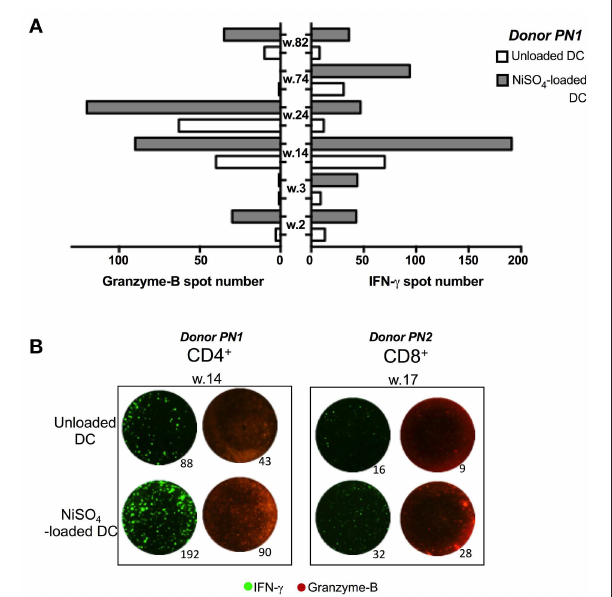
FIGURE 3 | Granzyme B production from CD4 + and CD8 + T cells recognizing nickel. (A) Granzyme-B (Grz-B)/ IFN- γ spots count